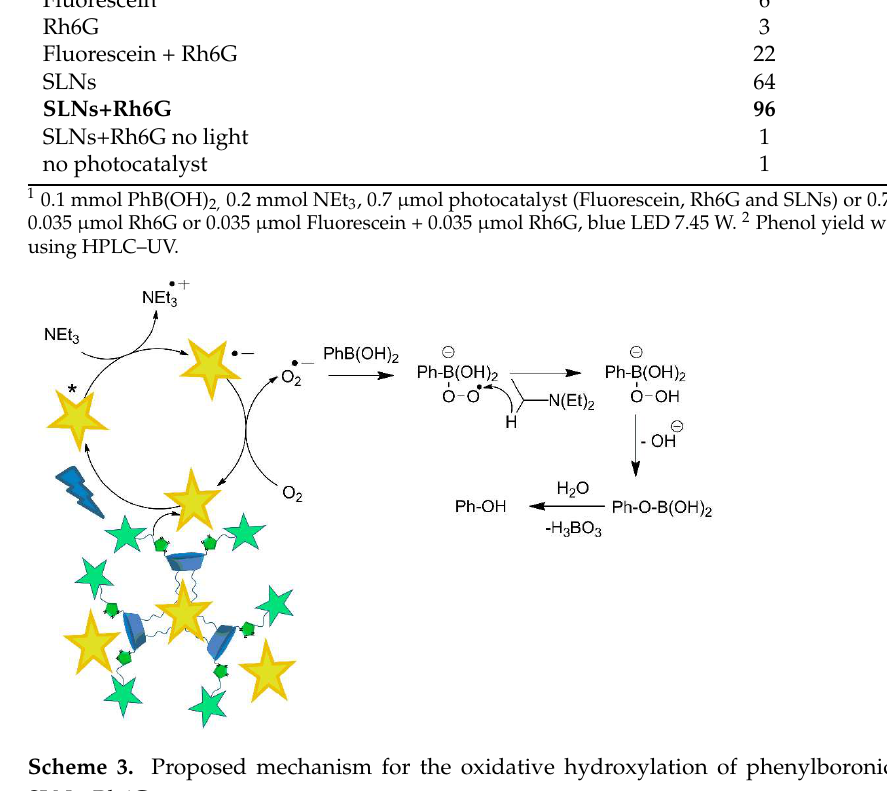
Table 3. HPLS–UV yield of phenol from photoredox hydroxylation of phenylboronic acid using different catalytic systems 1 .